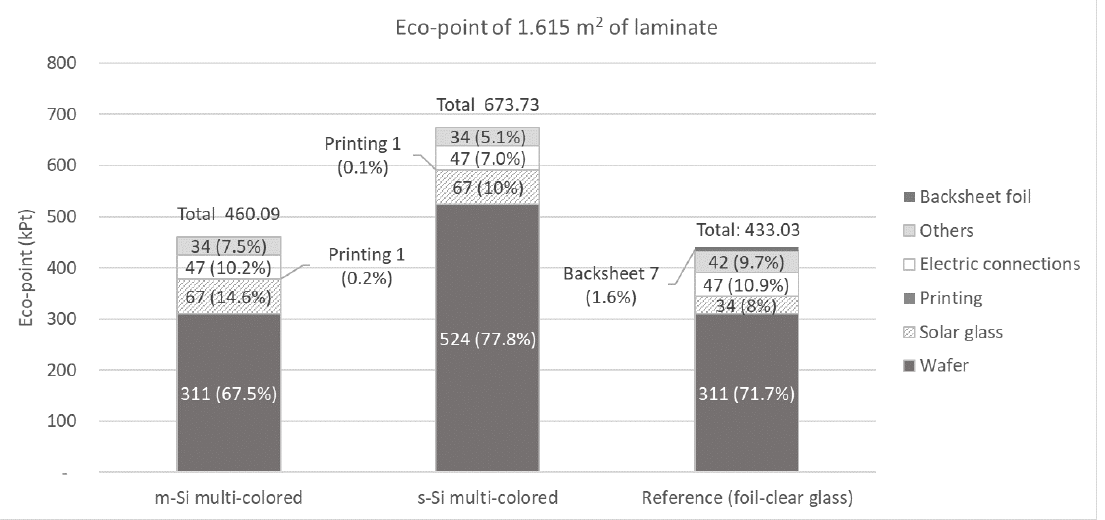
Figure 7. Eco-points for the production for various glass-glass PV laminate configurations. The reference data is for a 1.615 m 2